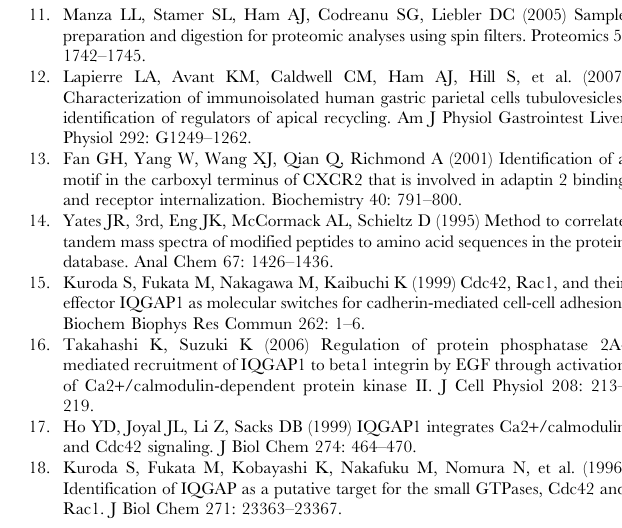
(TIF) Figure S3 No inhibition of IQGAP1-Cdc42 association when IQGAP1 1-160 fragment expressing in HEK-293 CXCR2 cells. HEK293-CXCR2 cells were transiently trans- fected with either vector control or IQGAP1 1-160 expression construct. Cells were stimulated with either CXCL8 (100 ng/ml) or carrier buffer for 5 min at 37 u C and co-immunoprecipitation was performed with anti-IQGAP1 polyclonal rabbit antibody (Santa Cruz, CA) and protein A/G agarose beads. Western blots were performed with anti-IQGAP1 or Cdc42 antibody, respec- tively. Experiments were repeated twice with similar results. (TIF) Figure S4 Only N-terminal of IQGAP1 1-160 fragment associates with CXCR2. The lysates of differentiated HL-60 cells were incubated with GST alone or various GST tagged fragments of IQGAP1. The GST pull-down products were resolved in a SDS-PAGE and detected by Western blot with anti-CXCR2 antibody (Santa Cruz Biotech, CA). Cell lysates were loaded as positive control and a ladder of fragments were observed due to the different forms of glycosylation of CXCR2 in differentiated HL-60 cells. CXCR2 was pulled down only with the GST tagged N- terminal and the GST-1-265 amino acid fragment of IQGAP1.